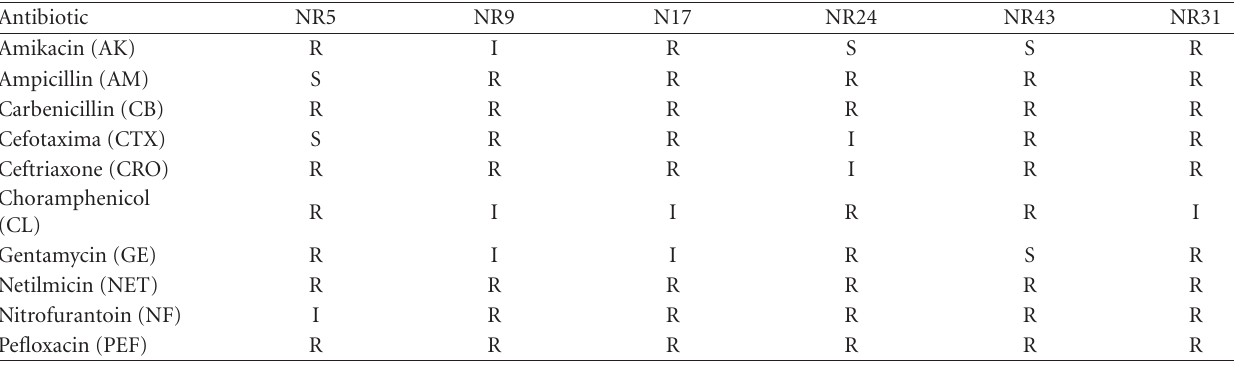
Table 3: Antibiogram results for